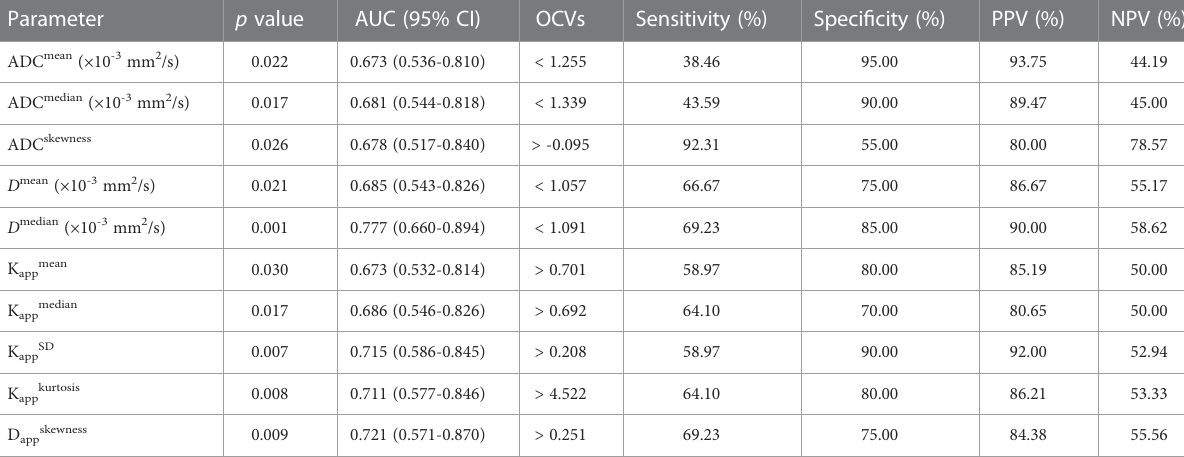
TABLE 6 ROC analysis results of whole-lesion histogram parameters for distinguishing lung cancer from benign lung lesions.